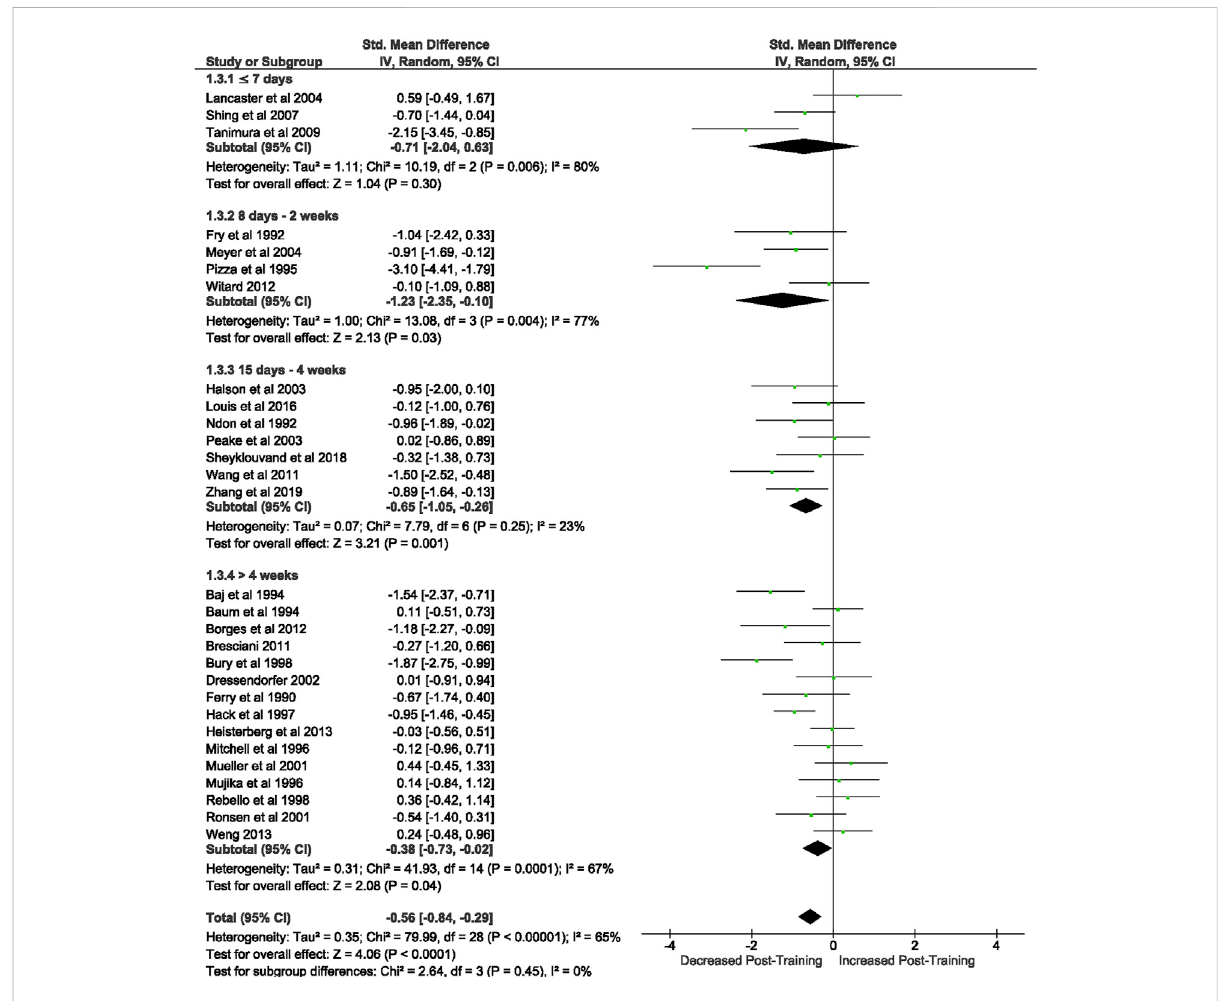
FIGURE 2 Effect of intensi fi ed training on resting lymphocyte counts, measured by FACS or Automated cell counter. Subgroup analysis is based on the duration of intensi fi ed training period; ≤ 7 days, 8 days — 2 weeks, 15 days — 4 weeks and > 4 weeks. All studies used human participants. CI Con fi dence